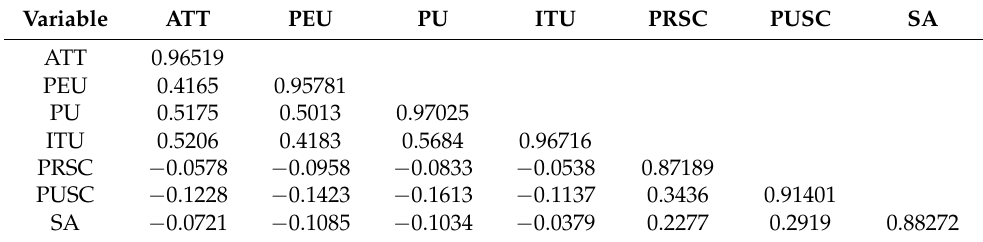
Table 3. Discriminant validity of latent